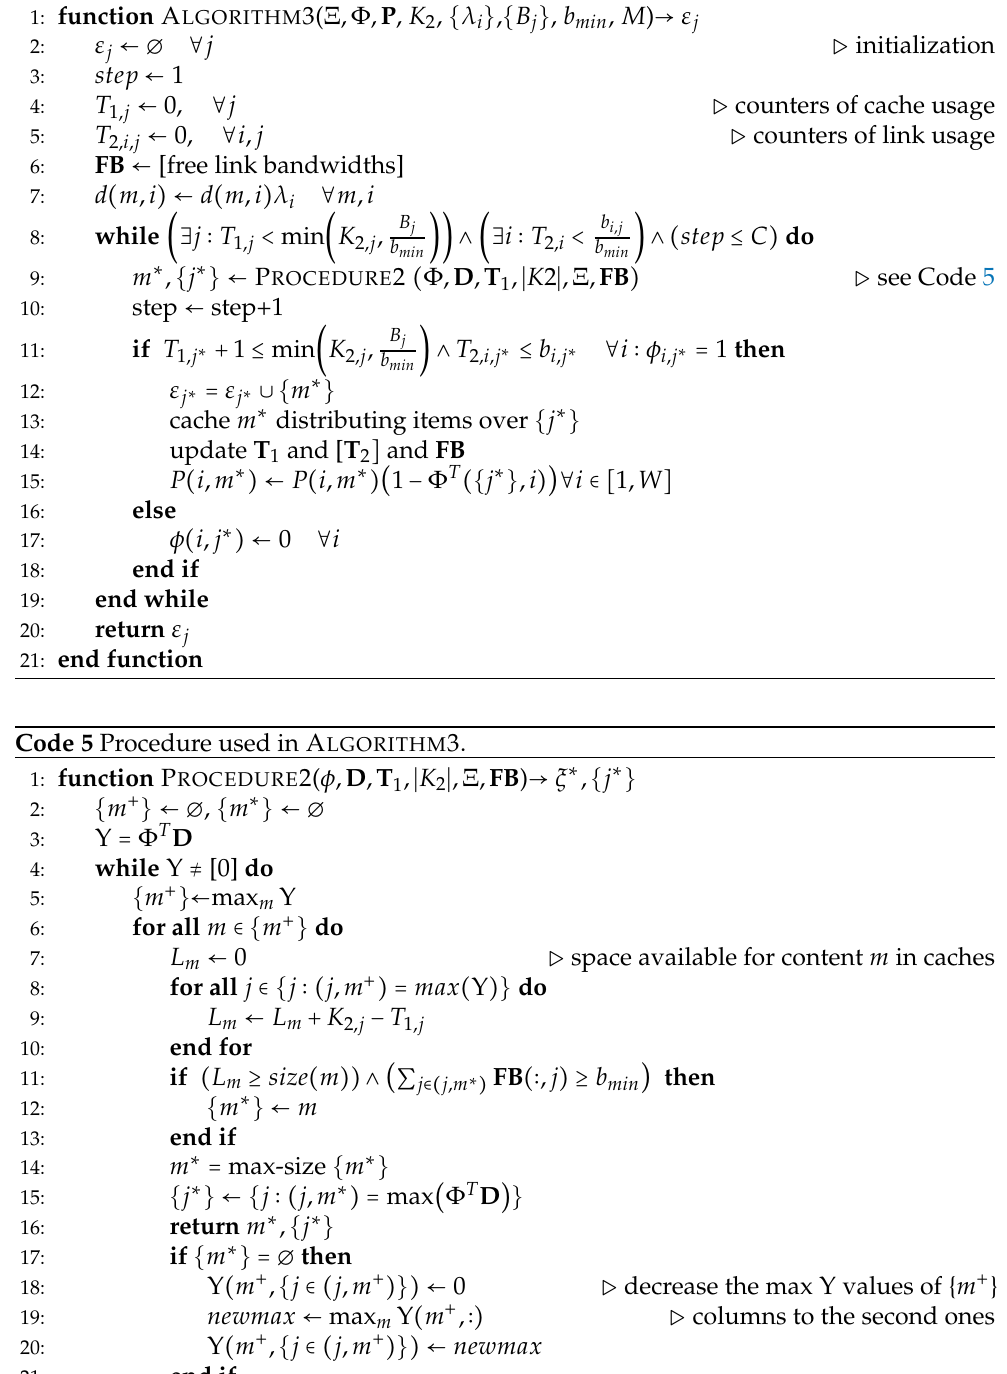
Code 4 Solution to Problem 6.